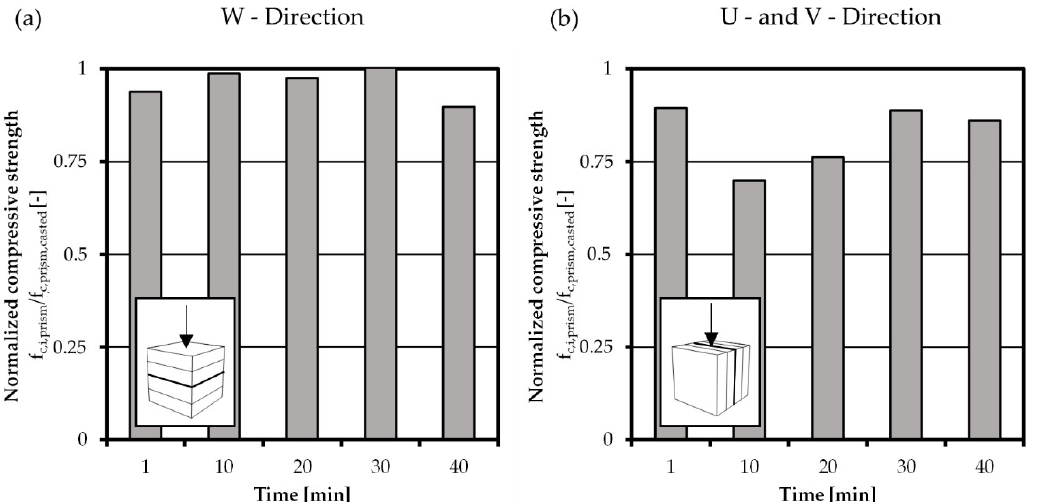
Figure 14. Development of compressive strength of printed specimens in ( a ) W-direction and ( b ) V-direction, with the respective arrangement of interfaces regarding the load direction.